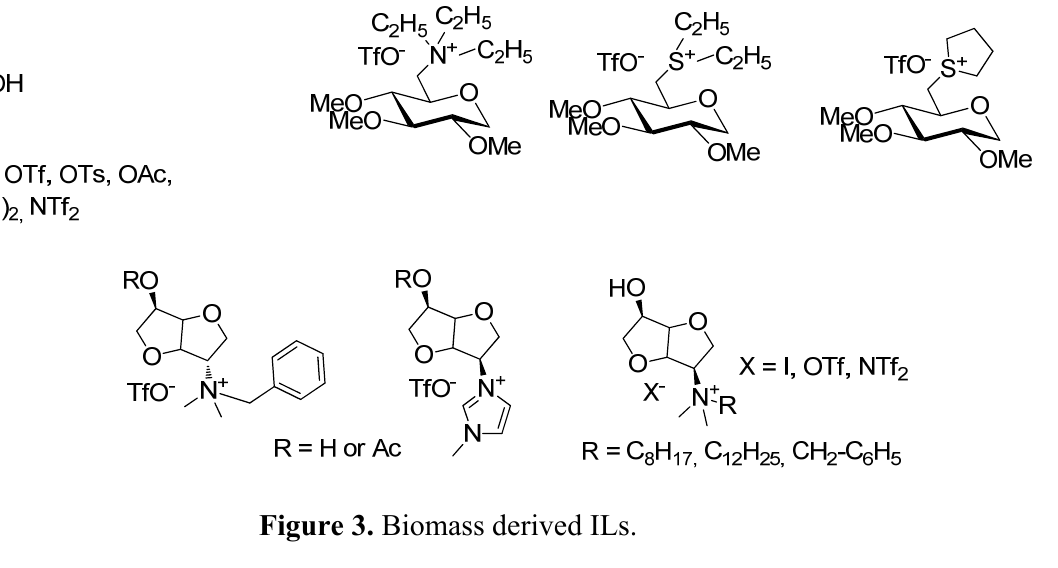
Figure 2. Carbohydrates-based ILs.